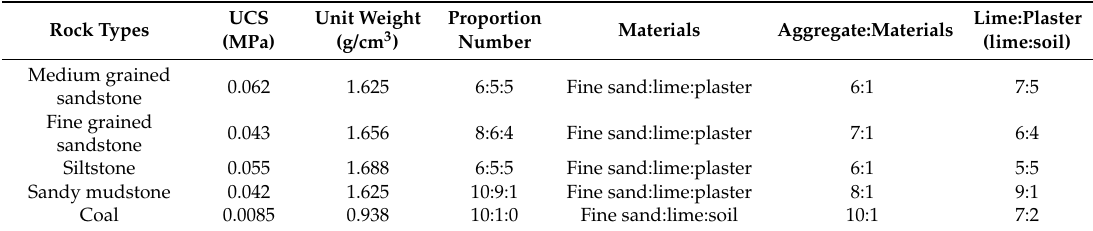
Table 4. Material parameters and proportion of different constituents in model materials.